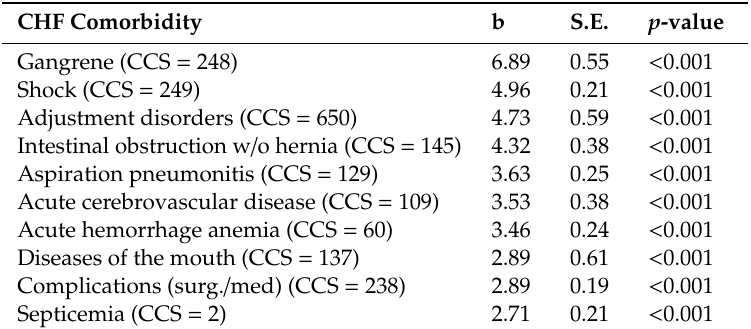
Table 3. Coe ffi cient analysis of the LOS using multiple linear regression. The table presents the top ten comorbidities associated with the highest LOS increase.